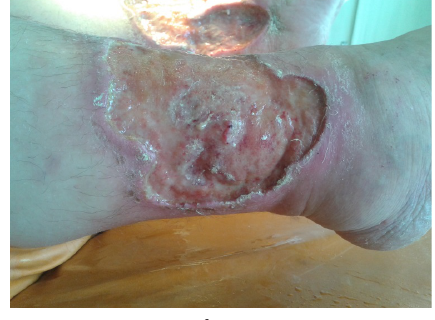
Fig. 1. Before treatment